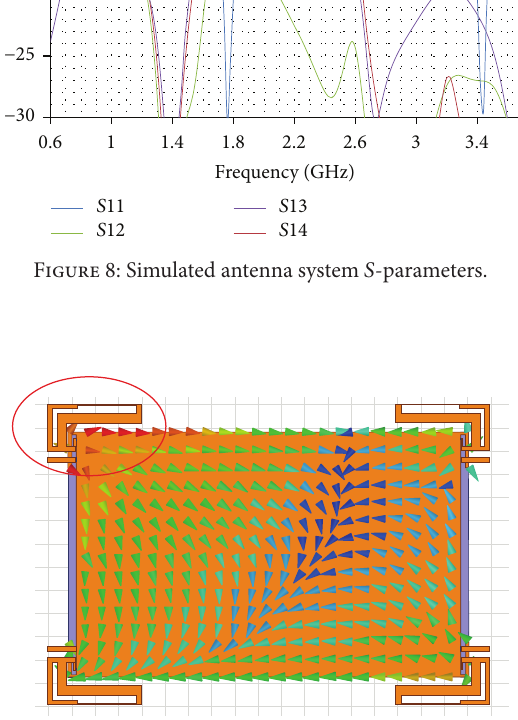
Figure 9: Current density on the chassis at 800MHz when Antenna 1 is